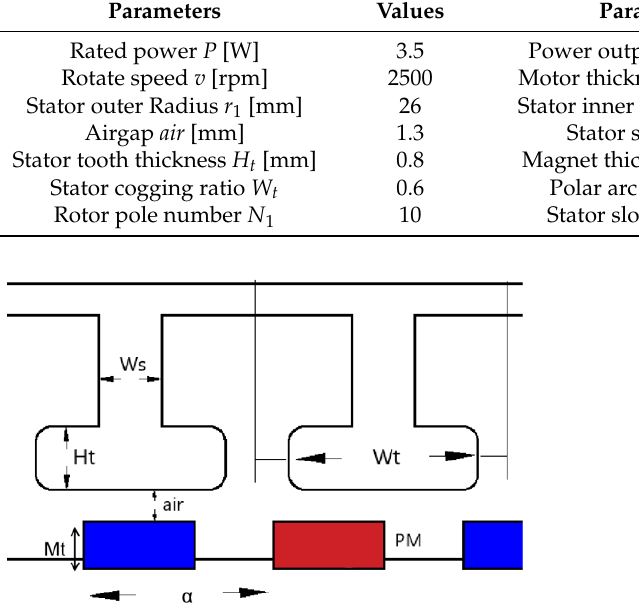
Table 2. Initial structural parameters and performance requirements of the auxiliary generator.